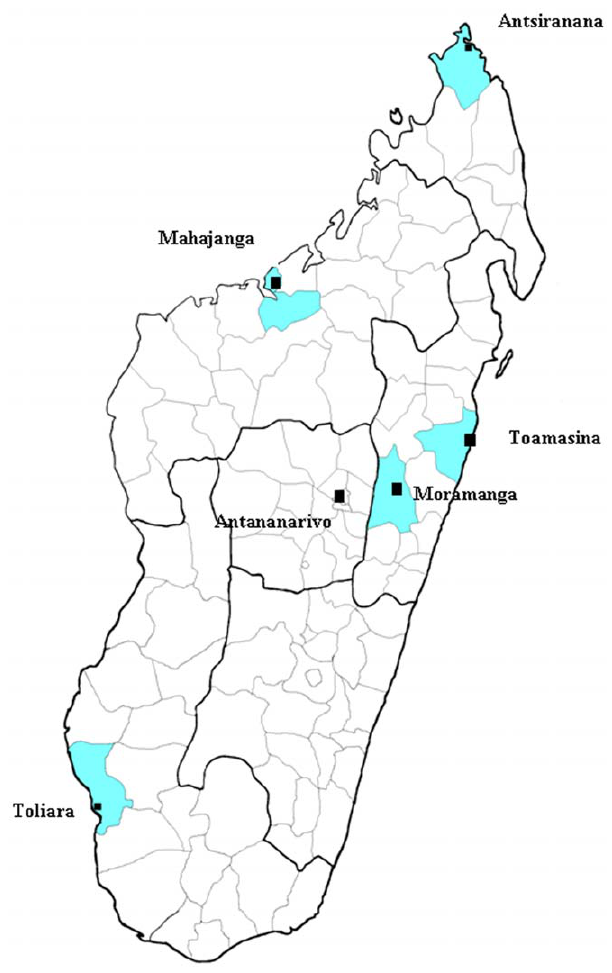
Figure 1. Map of Madagascar showing the five locations and districts (in blue) in which the field trapping survey was carried out. Square labels indicate cities.